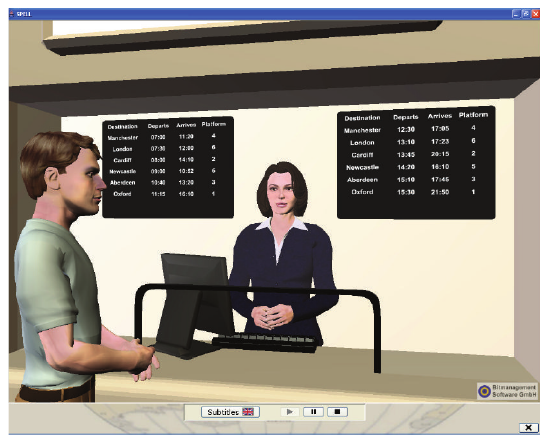
Figure 1: Virtual characters in interactive scenario “At the